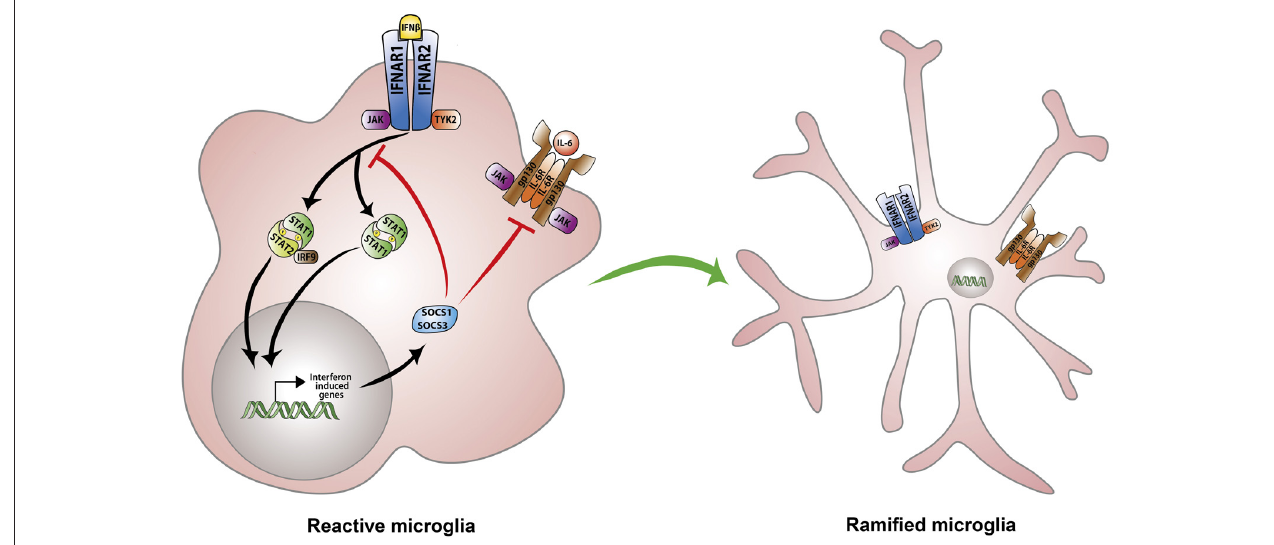
FIGURE 2 | Regulation of microglia responses by IFN- β signaling. IFN- β initiates signaling via binding to the heterodimeric IFN α / β receptor (IFNAR). IFNAR ligation triggers activation of the associated tyrosine kinases JAK1 and TYK2 which in-turn phosphorylate STAT1 and STAT2 transcription factors. STAT1 and STAT2 can also recruit IRF-9 to form a trimolecular complex IFN-stimulated gene factor 3 (ISGF3). STAT homodimers or heterodimers activate the transcription of interferon-stimulated genes (ISGs) including suppressor of cytokine signaling 1 (SOCS1) and SOCS3 as part of a negative feedback loop. SOCS1 and SOCS3 inhibit JAK/STAT and IL-6 signaling thereby preventing excessive cytokine stimulation and dampening microglia